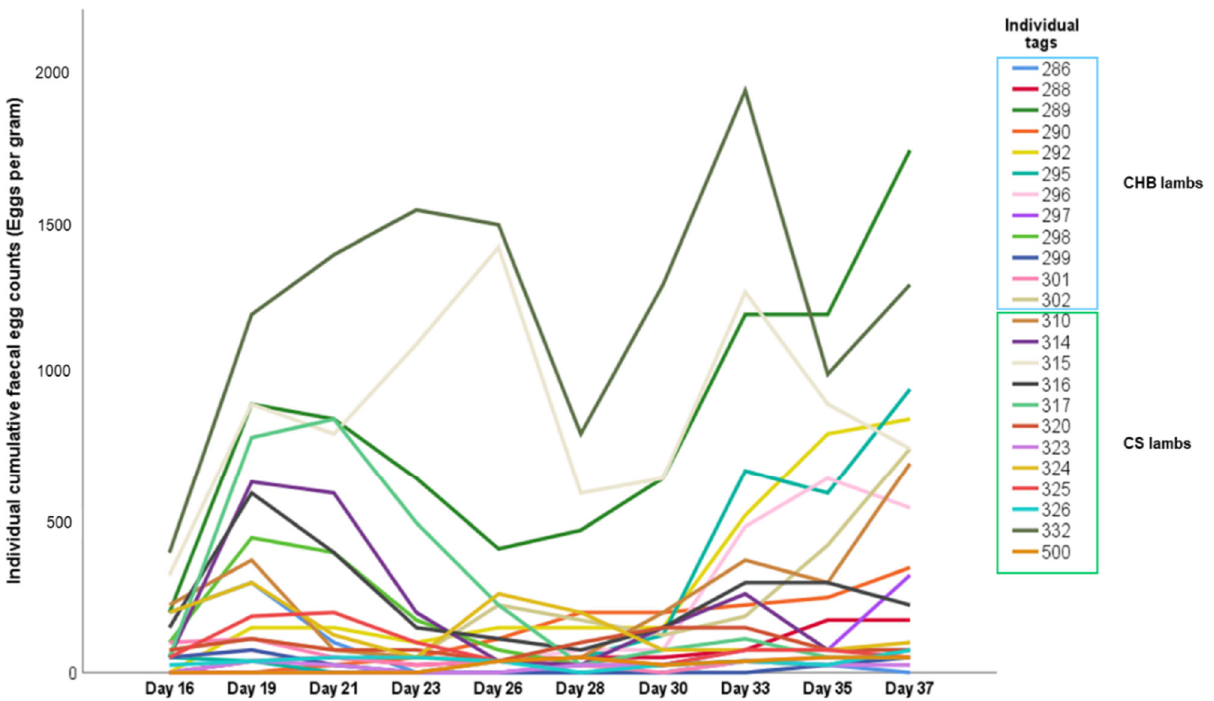
Figure 1. Parasitological variables in three ‐ month ‐ old sheep after trickle infection with Teladorsagia circumcincta infective larvae. Total cumulative faecal egg counts ( A ), worm burden at post ‐ mortem ( B ), length of female worms ( C ), and eggs in utero ( D ) are shown as individual means. Animal tags in the X ‐ axis are arranged from left to right according to ascending mean value ( n = 24).